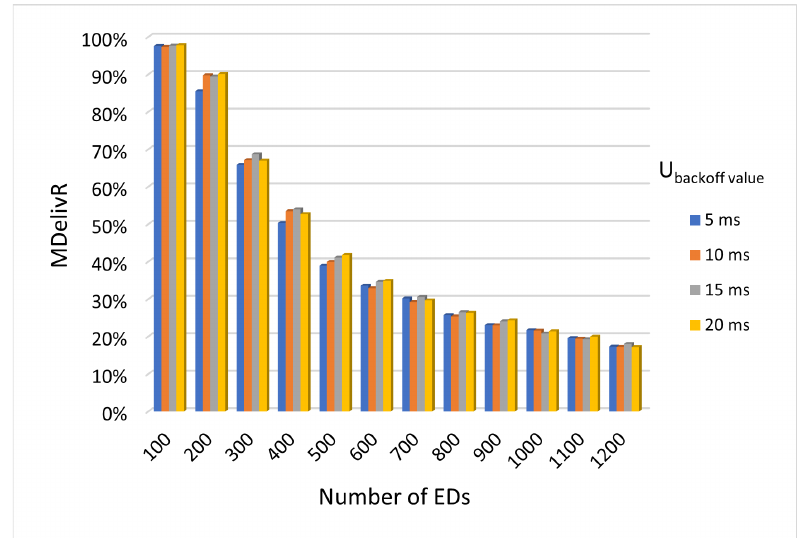
Figure 7. Case C ( MAC max = 15): MDelivR versus the number of EDs with different backoff nBackof f unit durations. Table 10. Case A ( MAC max = 5): Average and maximum e2eD varying the number of EDs and nBackof f the U backof f parameter.